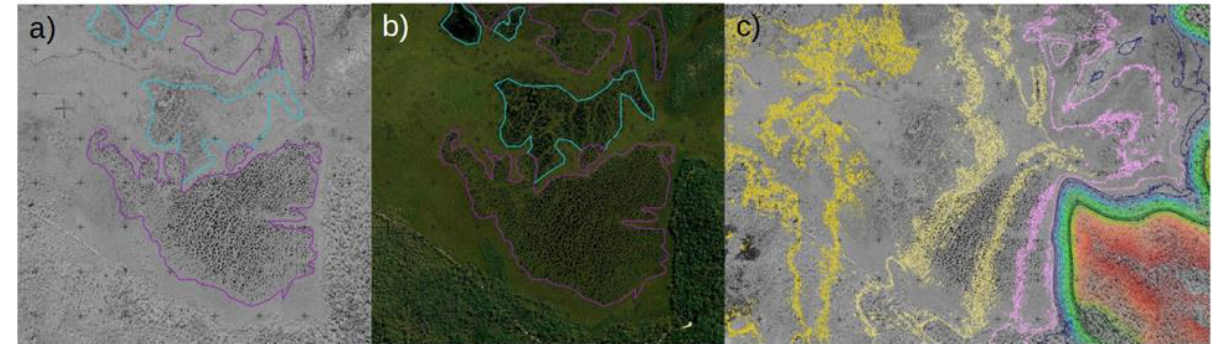
Figure 3. Aerial imagery of a small fen with irregular ‘reticulate’ patterning near Moon Point, Fraser Island (153.06 °E, 25.215 °S). Tick marks on a) and b) represent 200 m intervals. Darker shades within the pattern represent open water. On panel c), altitude is represented by 1 m contours, where yellow represents 1 m and 2 m a.s.l., dark blue 3 and 4 m a.s.l., etc. The top of the south-eastern sand ridge is at 60 m a.s.l.